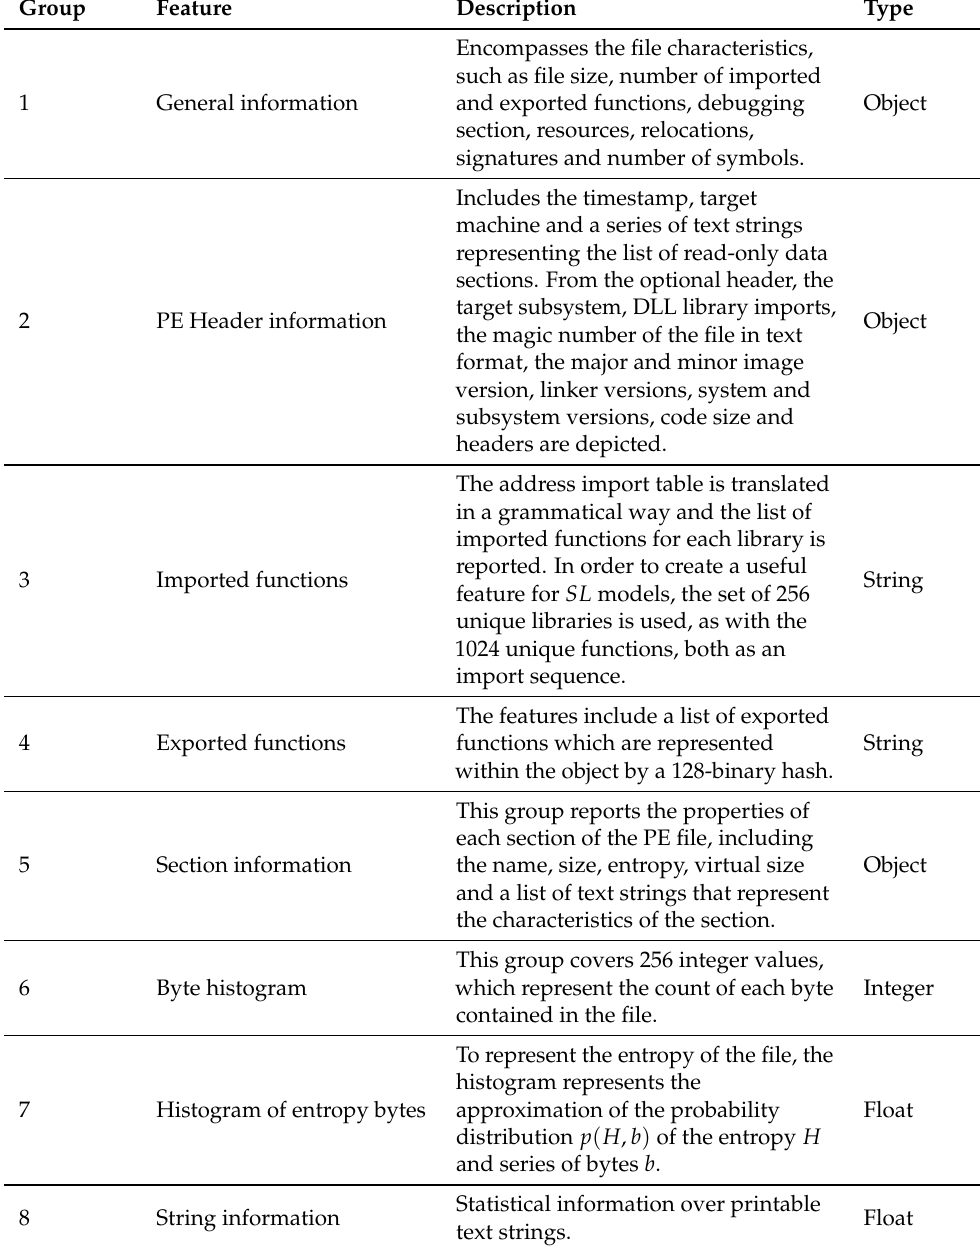
Table 2. Dataset features, under the EMBER